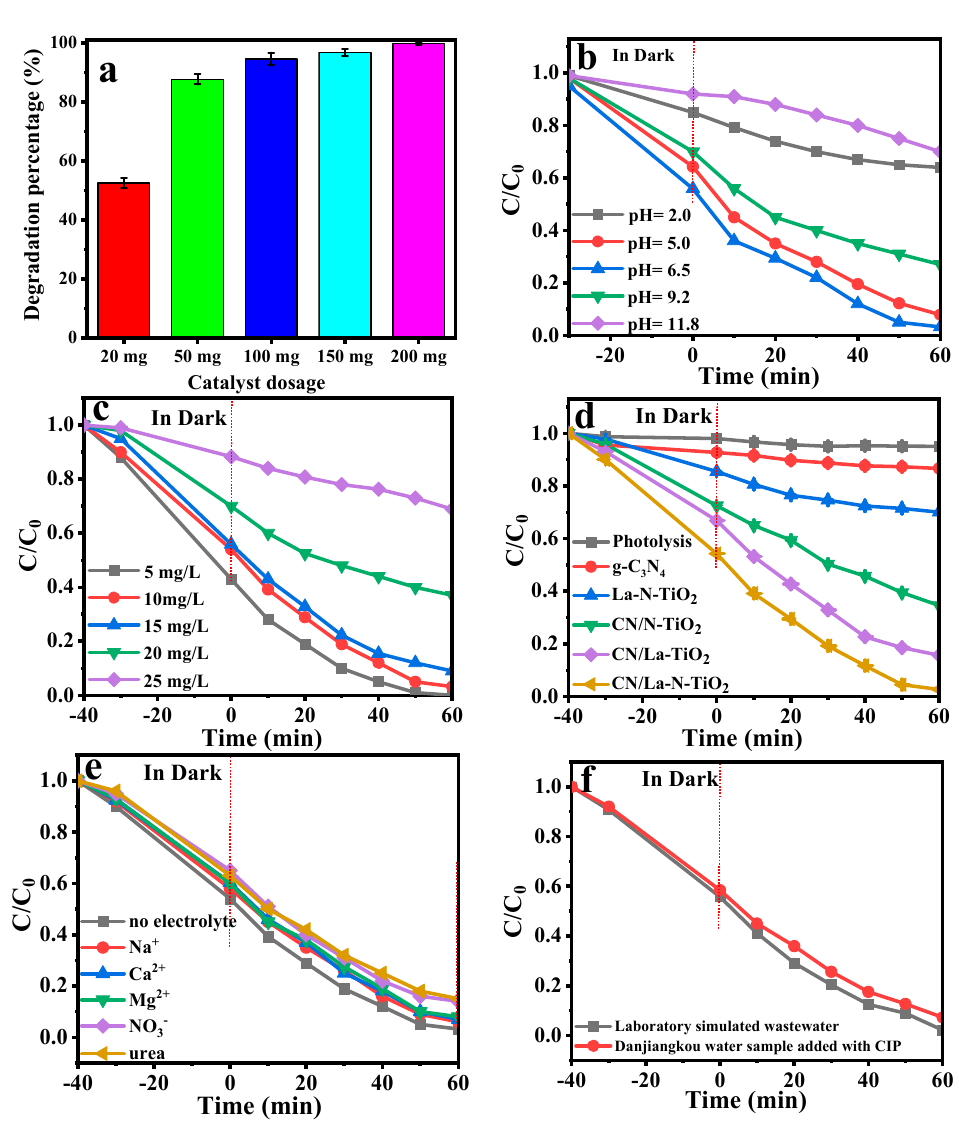
Figure 7. Photocatalytic degradation of ciprofloxacin under simulated solar- light irradiation ( a ) amount of catalyst, ( b ) at different initial pH, ( c ) Effects of the initial concentration of CIP (5–25 mg/L), ( d ) by different photocatalysts, ( e ) Effect of various electrolytes, and ( f ) in actual water samples in the presence of CN/La-N-TiO 2 .